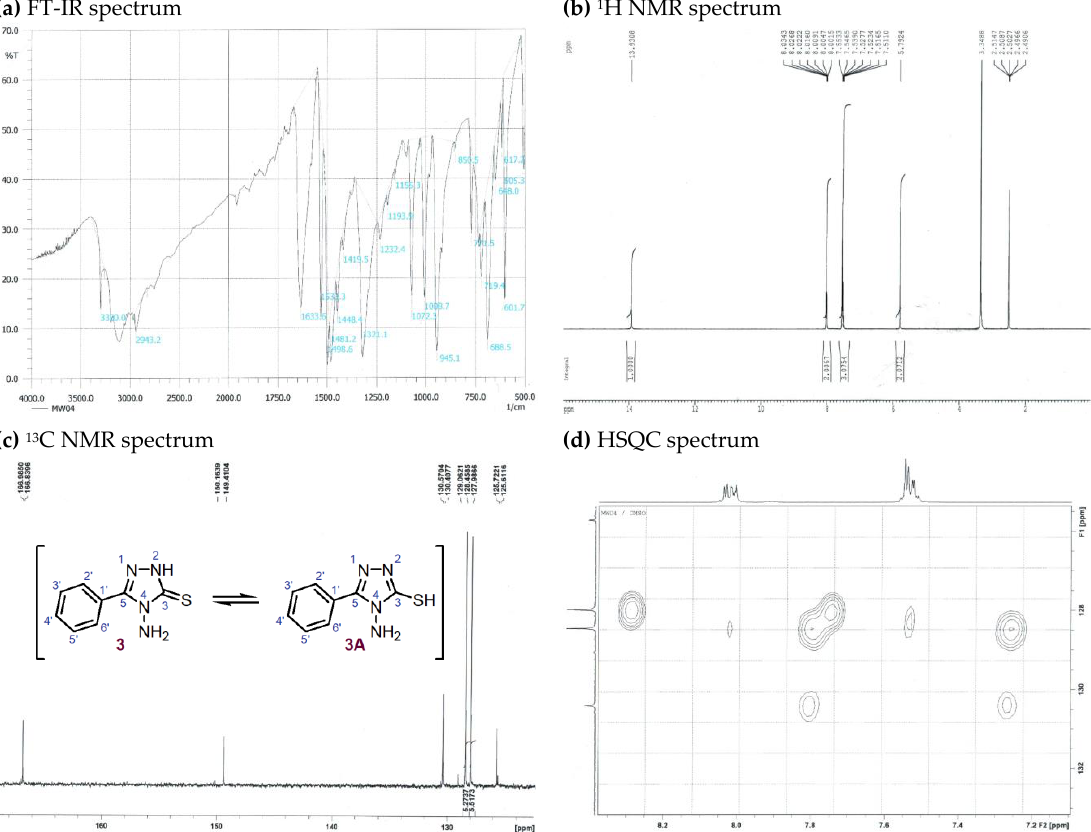
Figure 2. Spectroscopic characterization for 1,2,4-triazole 3 .